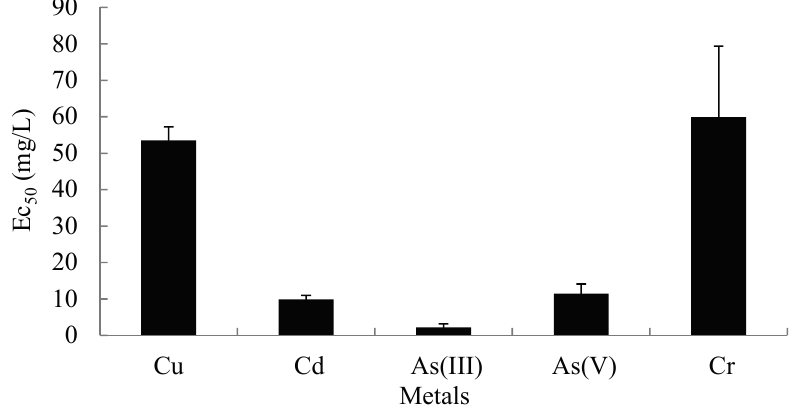
Figure 5. Two representative results of bioluminescence activities of strain KG1206 under different conditions (mixtures of arsenic as well as Cu and Cr in the presence of 0.5 mM